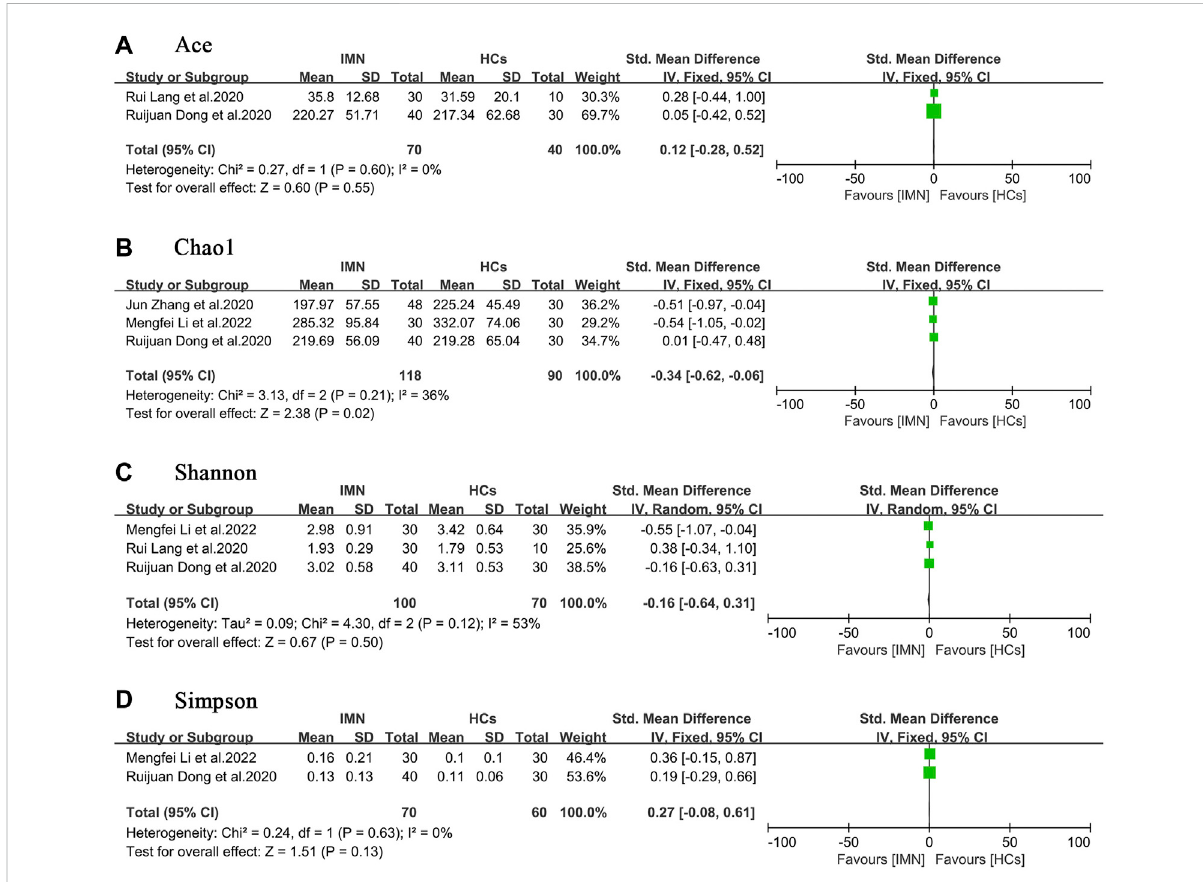
FIGURE 2 Forest plots of alpha diversity in the gut microbiota of patients with IMN compared with HCs. (A) Ace index, SMD = 0.12, [ − 0.28, 0.52]; p = 0.55; I 2 = 0%; (B) Chao1 index, SMD = − 0.34, [ − 0.62, − 0.06]; p < 0.05; I 2 = 36%; (C) Shannon index, SMD = − 0.16, [ − 0.64, 0.31]; p = 0.50; I 2 = 53%;